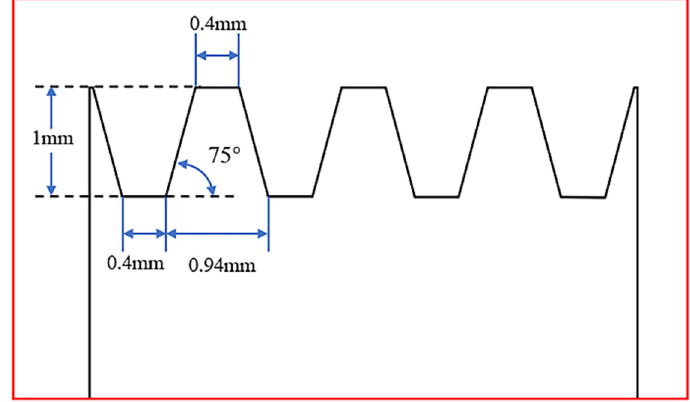
Processes 2023 , 11 , 560 Figure 2. Structure and size of constraint block. Figure 2. Structure and size of constraint block.